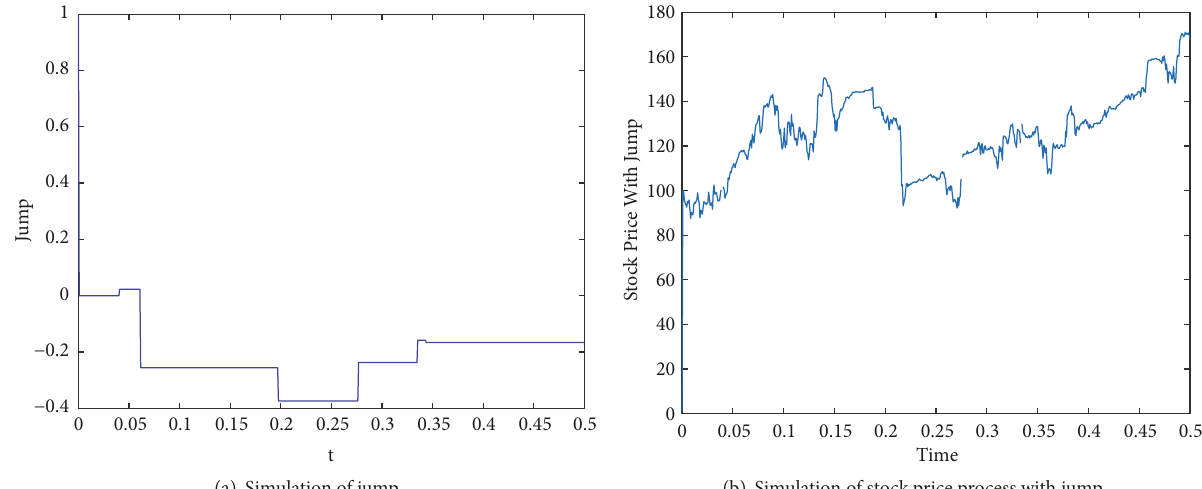
Figure 4: Simulation of jump